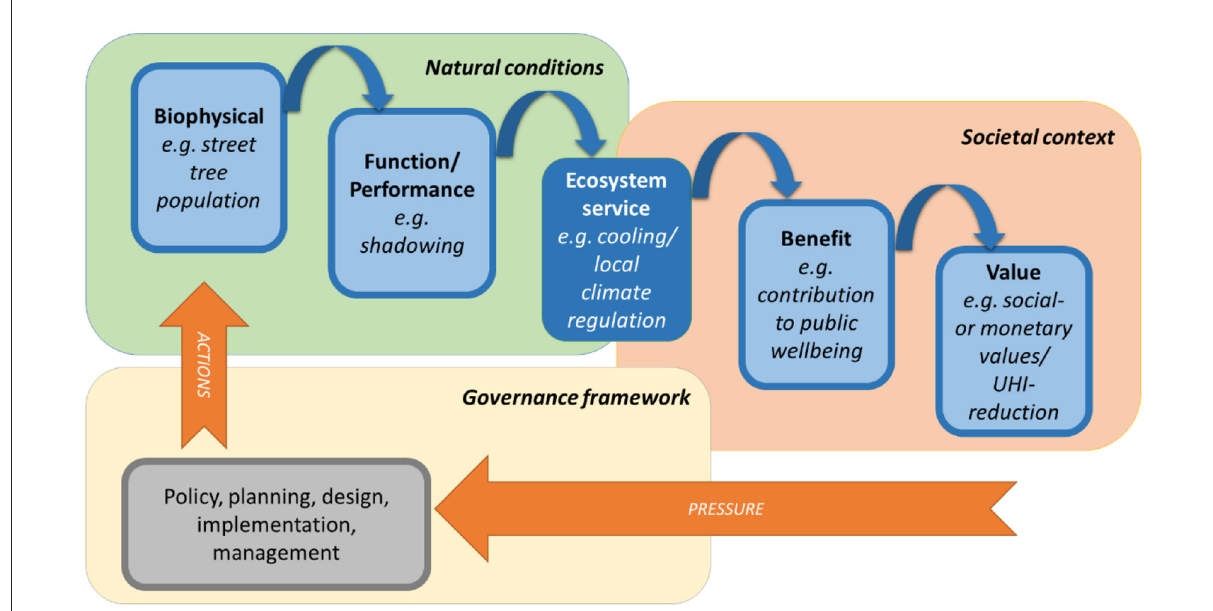
FIGURE1 Cascade Model of ecosystem services. The performance of Urban Green Infrastructure (UGI) to support functions and deliver services and benefits to the gain of the society are dependent on a multifaceted context (TEEB, 2010; Potschin-Young et al., 2018), with interrelationships between the physical realm (natural conditions), social values and norms, and governance and management